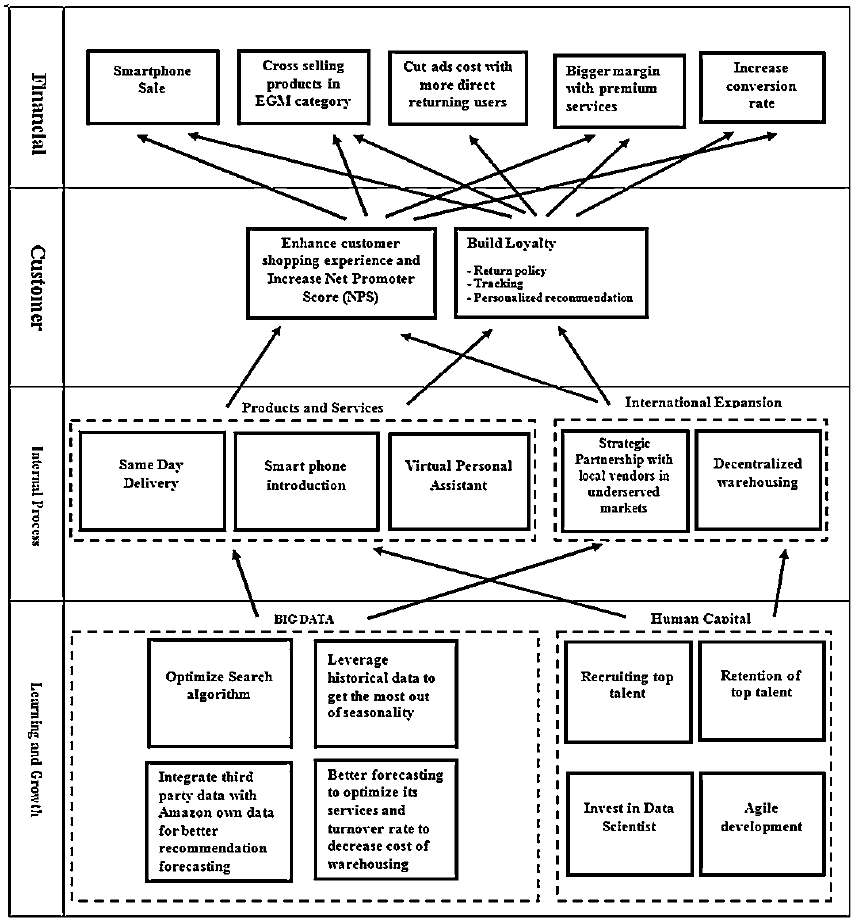
Fig. 13. Amazon Strategy